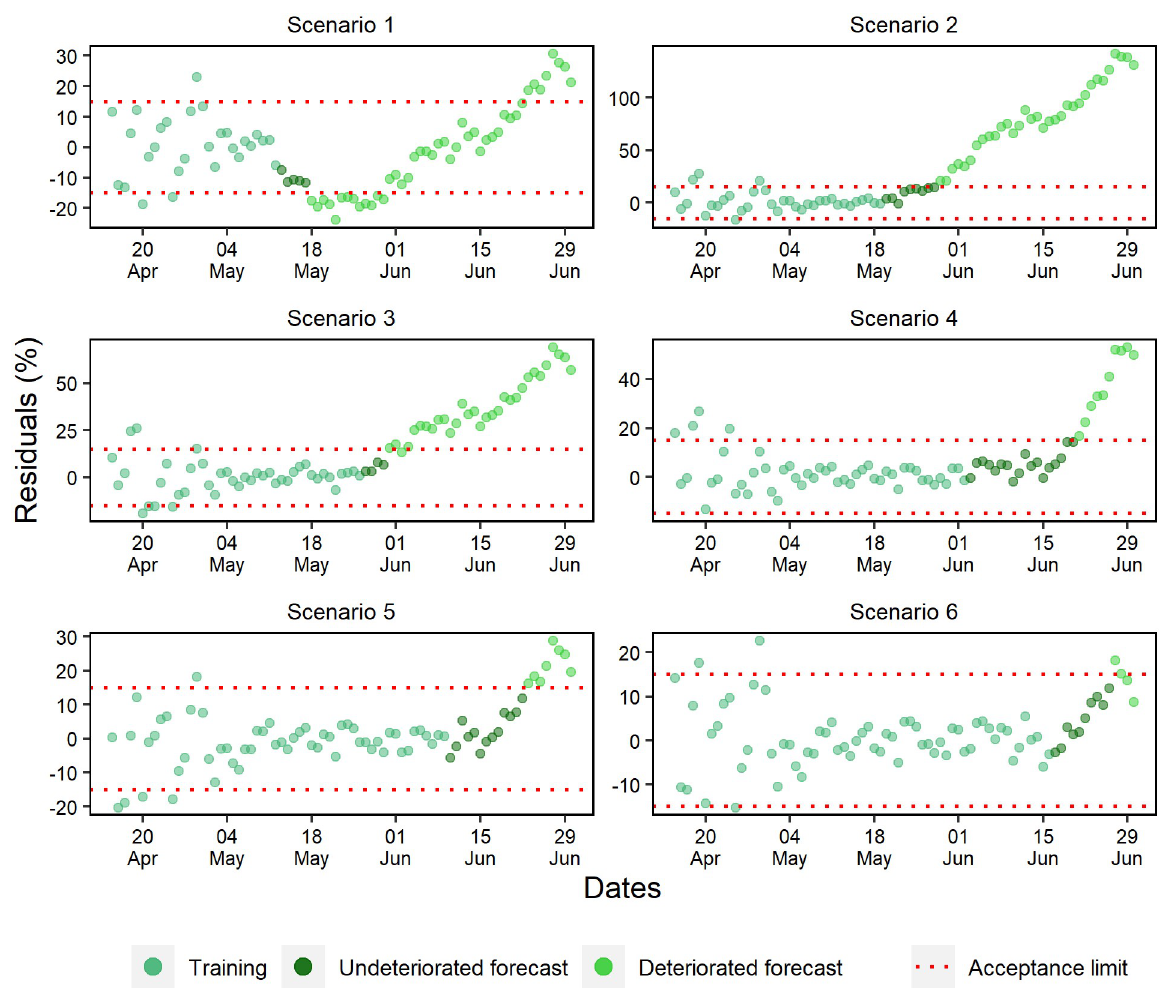
Fig 14. Percentual residuals for standard hospital beds occupancy of the 6 analyzed